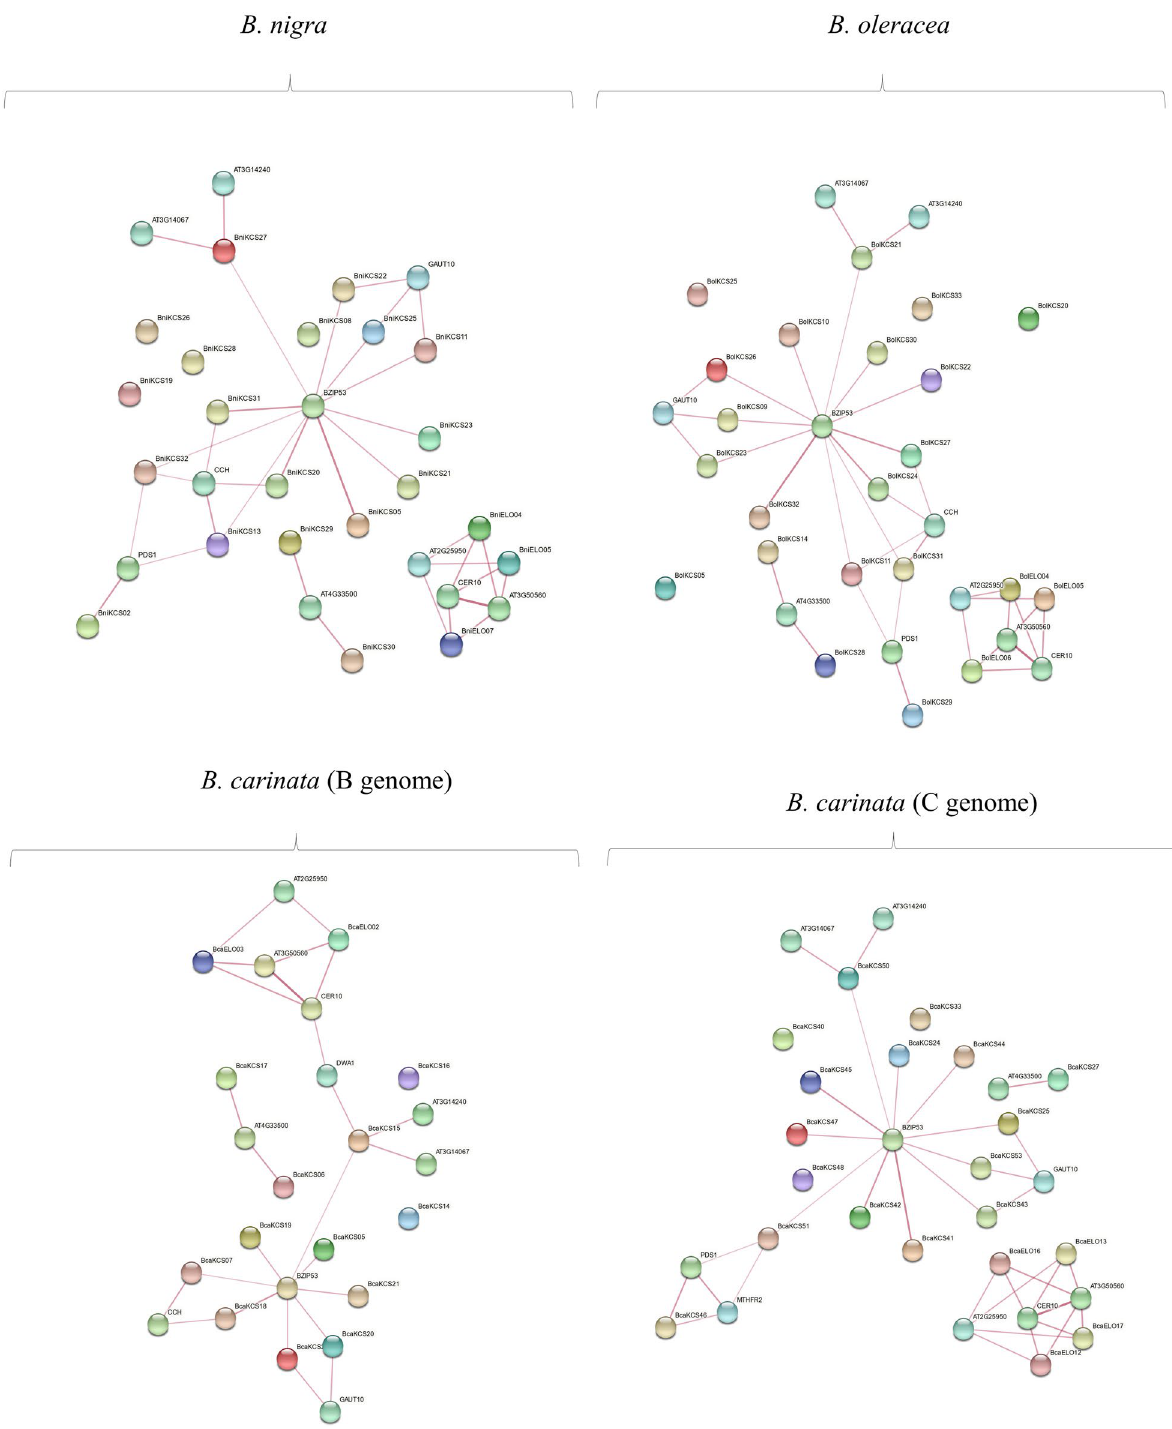
Figure 4. Predicted protein protein network of identified KCS and ELO proteins with other proteins. The strings and their intensity are indicating the interections of the members and the confidence